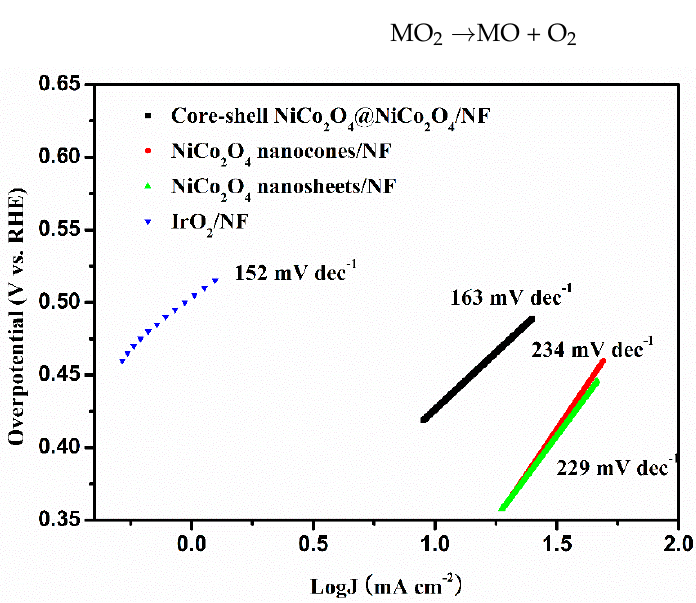
Figure 7. The Tafel plots of core-shell NiCo 2 O 4 @NiCo 2 O 4 , NiCo 2 O 4 nanosheets, NiCo 2 O 4 nanocones and IrO 2 in O 2 -saturated 1 M KOH solution.